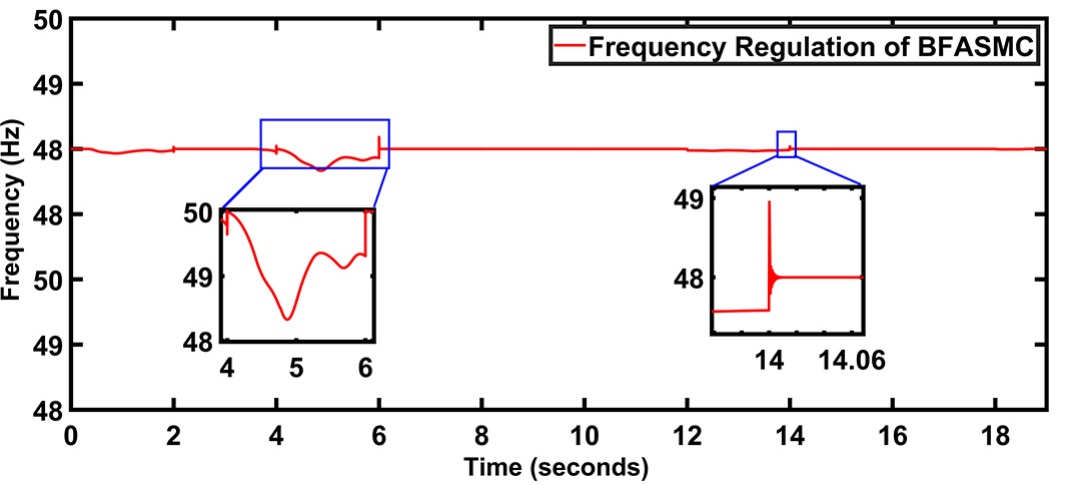
Figure 14. Frequency regulation at the VSI side.